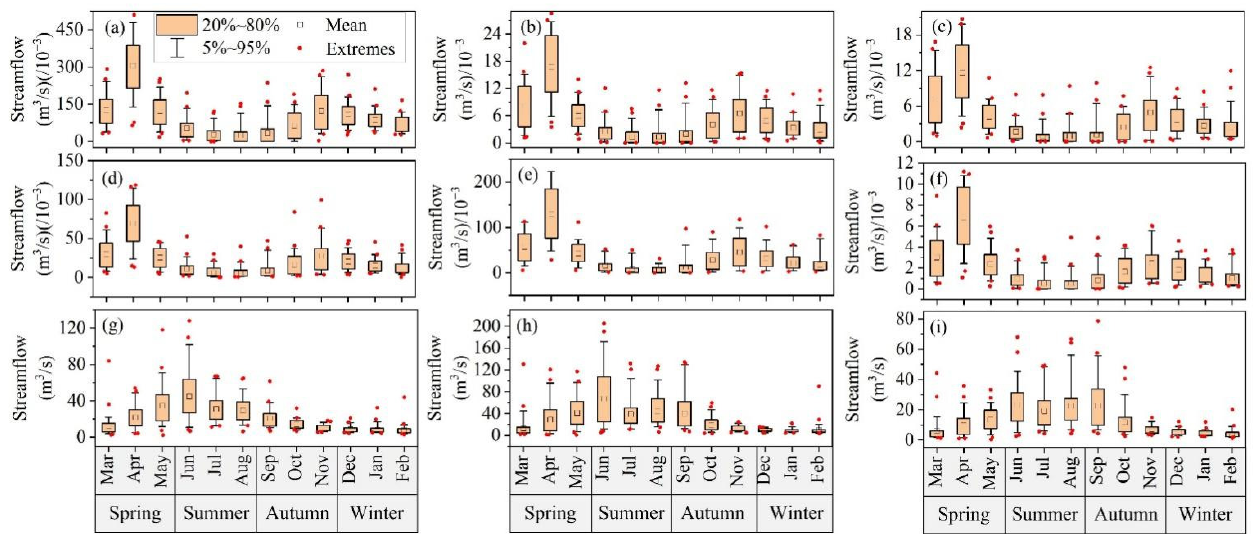
Figure 3. Box-plots for monthly streamflow in different months within a year in the Harp Lake ( a – f ) and Dongjiang River ( g – i ) catchment; ( a ) HP0, ( b ) HP3, ( c ) HP3a, ( d ) HP4, ( e ) HP5, ( f ) HP6, ( g ) Yuecheng, ( h ) Lantang, and ( i ) Jiuzhou.